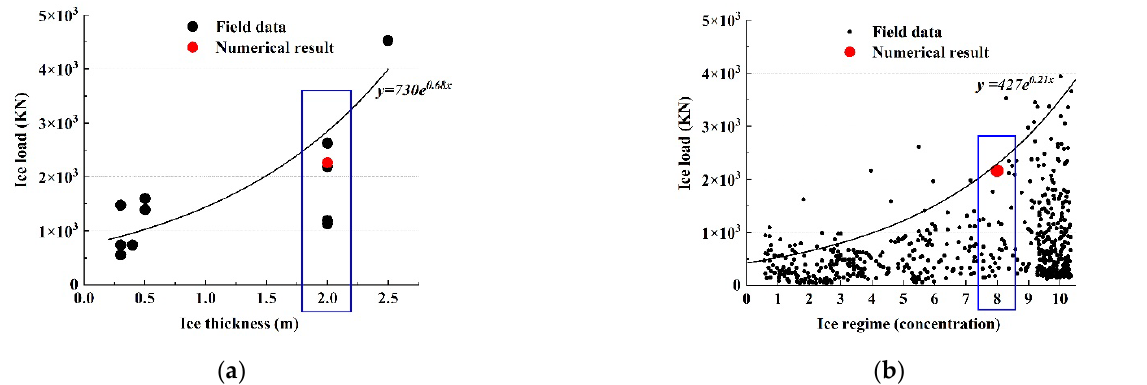
Figure 12. Comparison between the numerical simulation results and the field data of the Kulluk platform. ( a ) Ice thickness as the independent variable; ( b ) ice concentration as the independent variable.